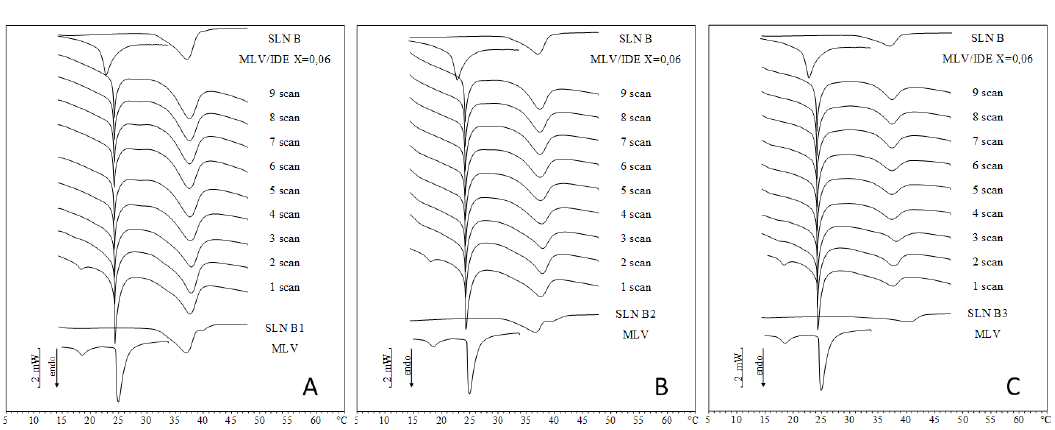
Figure 4. DSC scans during the interactions of IDE-loaded SLN with MLV liposomes. A = SLN B1; B = SLN B2; C = SLN B3.